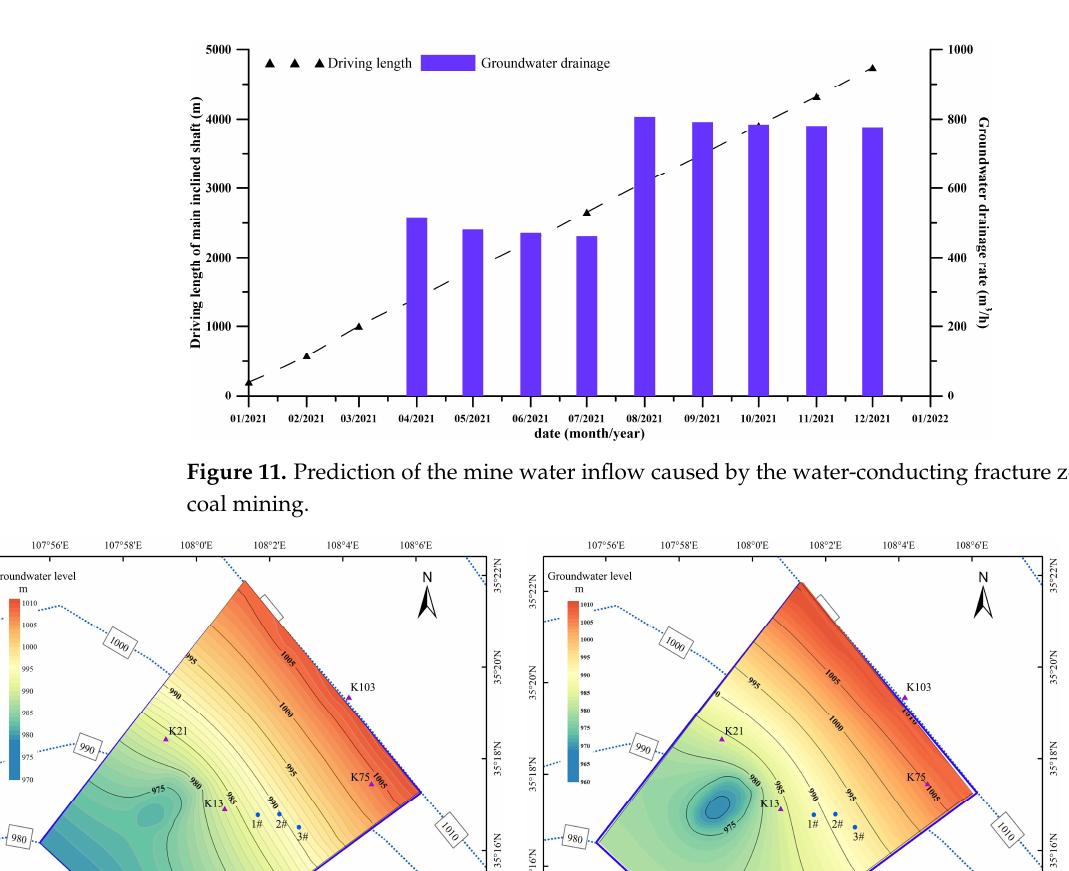
Figure 11. Prediction of the mine water inflow caused by the water-conducting fracture zone under coal mining.